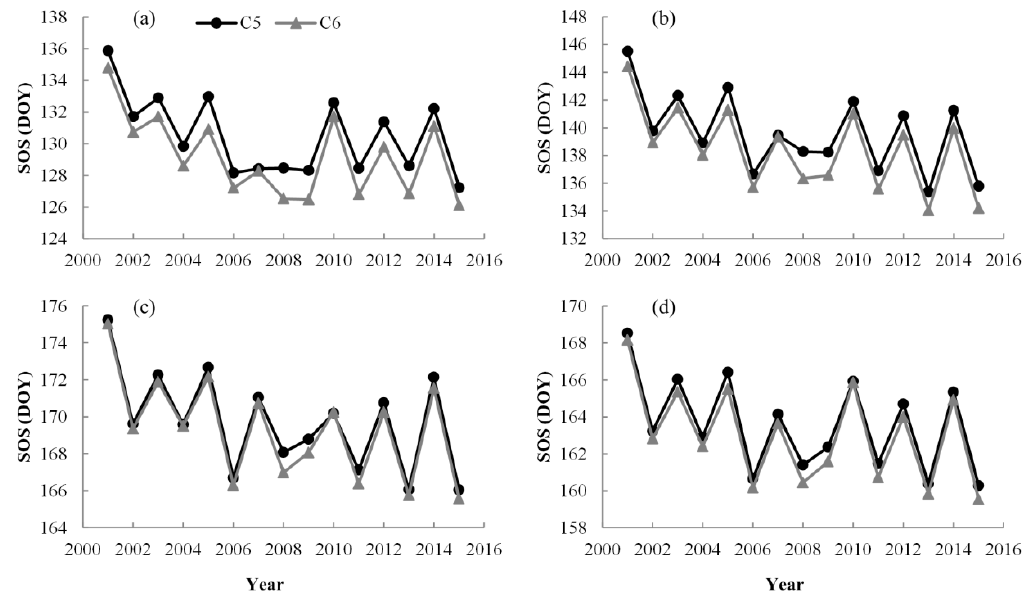
Figure 4. Comparisons of annual regional average start of growing season from MODIS C5 (SOS C5 ) and C6 (SOS C6 ) for the alpine grassland on the Tibetan Plateau during 2001–2015 for different methods: ( a ) Maximum Curvature Change (MCC); ( b ) Dynamic Threshold 0.2 (DT2); ( c ) Dynamic Threshold 0.5 (DT5); and, ( d ) Maximum Slope (MS). Table 2. Summary statistics for the regional average start of growing season derived from C5 and C6 NDVI products for the alpine grassland on the Tibetan Plateau during 2001–2015.